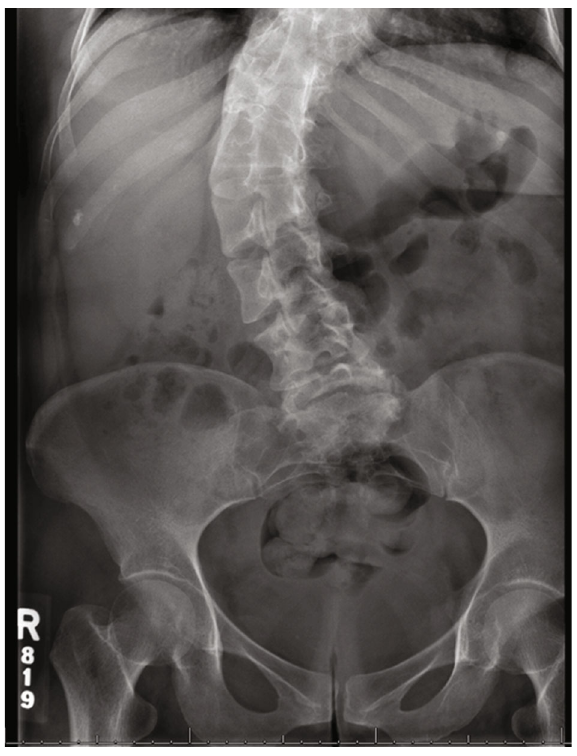
Figure 2: KUB and pelvic XR of this patient shows characteristic severe scoliosis often seen in